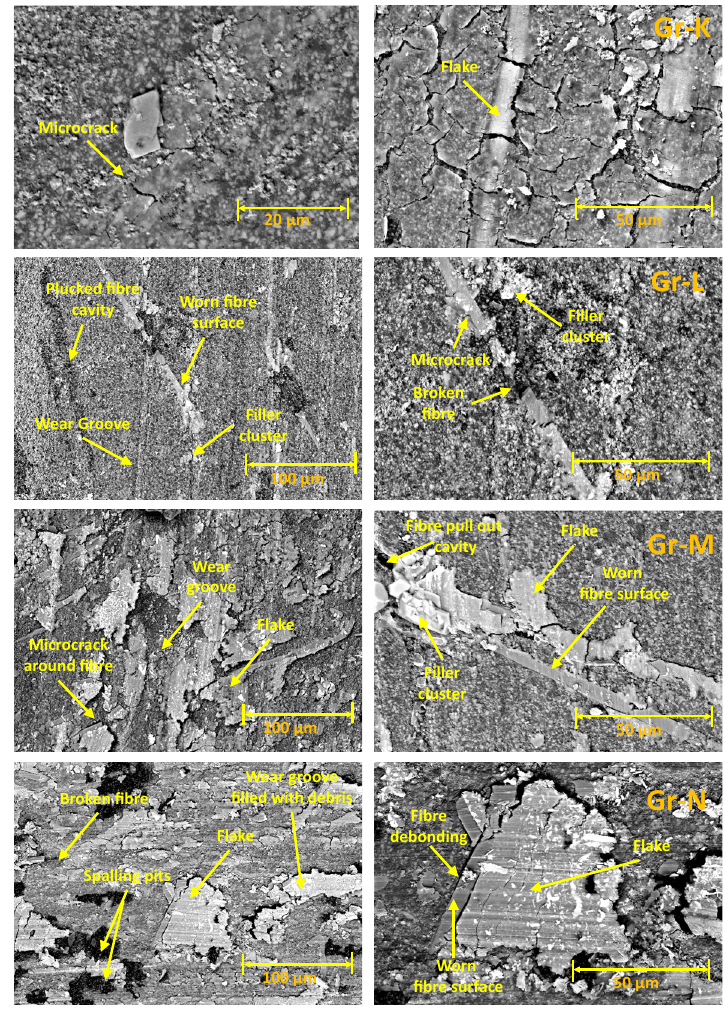
Figure 8. SEM images of wear surface for Rotary Test (Groups K-N): No Fibre, 5% 50AR, 5% 70AR and 5% 100 AR